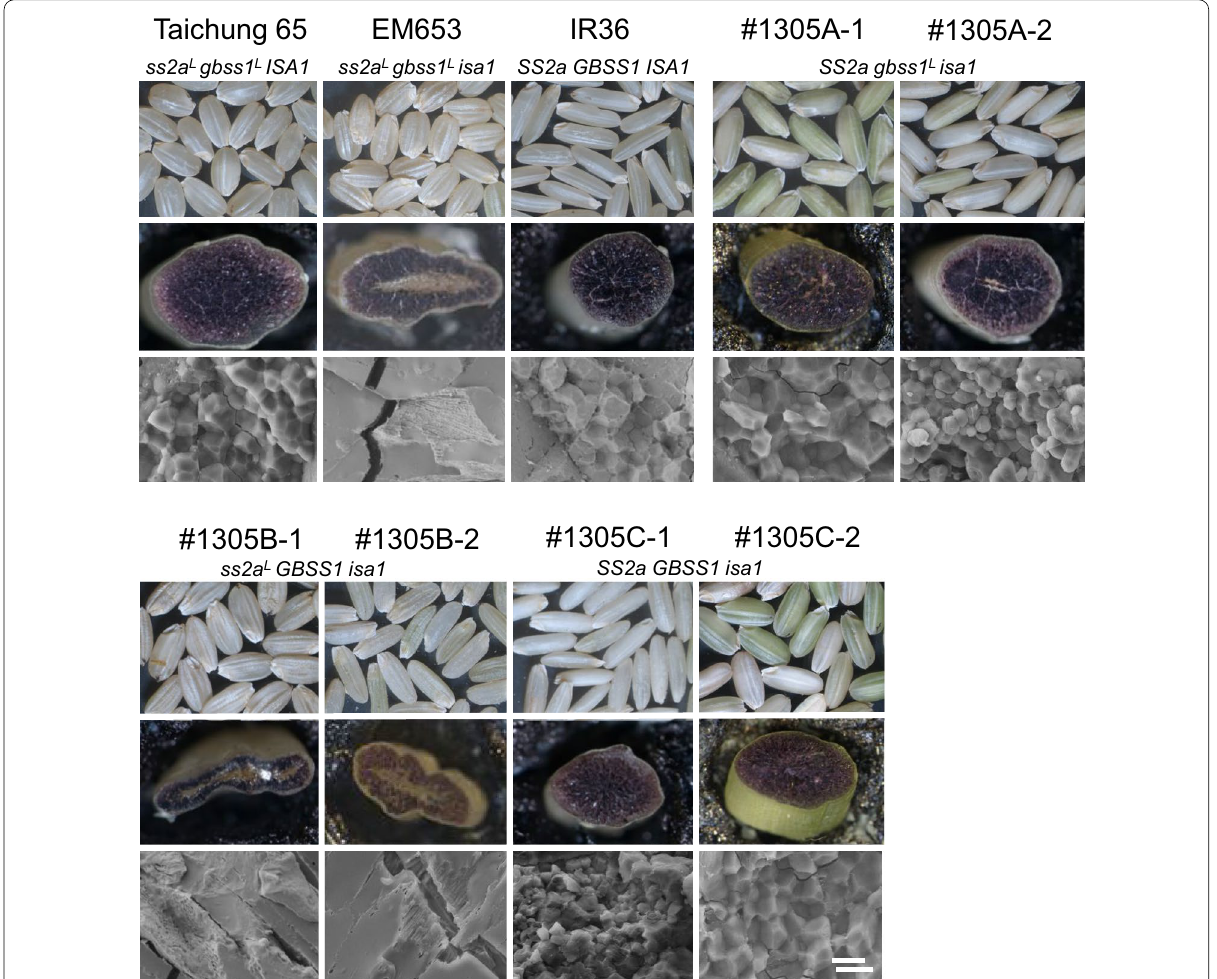
Fig. 5 Analysis of rice seed morphology. Images show the morphologies of dehulled mature rice seeds (top), stereo-micrographs of iodine-stained cross-section of mature seeds (middle), and scanning electron micrographs of the central region of mature seeds (bottom). Data were obtained from Crofts et al.